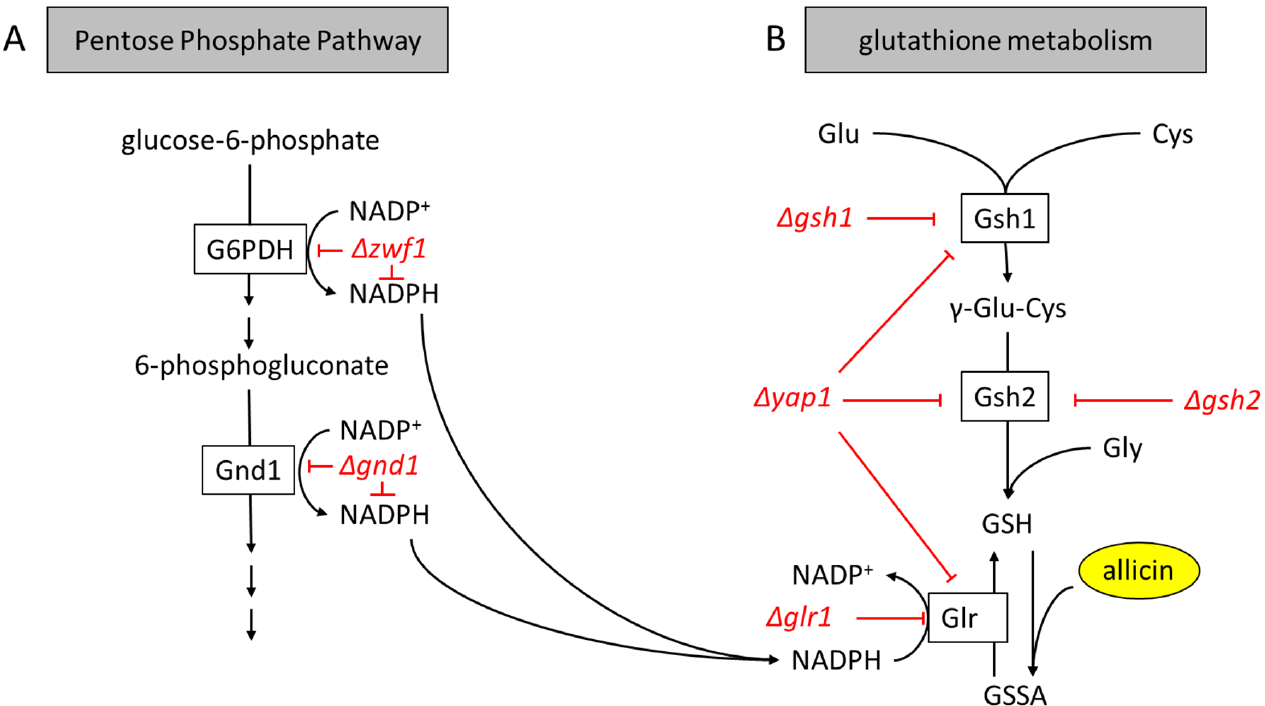
Figure 3. Summary of mutants in GSH synthesis and metabolism shown to affect allicin resistance. The diagram shows ( A ) the interplay between the NADPH-generating steps of the Pentose Phosphate Pathway and ( B ) GSH synthesis and metabolism. The steps at which the respective deletion mutants ( ∆ zwf1, ∆ gnd1, ∆ yap1 , ∆ gsh1, ∆ gsh2, ∆ glr1 ) act in yeast cells are shown in red. Allicin reacts directly with reduced glutathione (GSH) to form S -allylmercaptoglutathione (GSSA). The Pentose Phosphate Pathway provides NADPH as an electron donor for the enzyme glutathione reductase (Glr), that reduces GSSA to GSH and allylmercaptan (ASH, prop-2-ene-1-thiol). Yap1 is the central regulator for the oxidative stress response in yeast and activates several genes important for the antioxidant response, including gsh1 and gsh2 whose protein products catalyze GSH biosynthesis, and glr1 which is necessary for the reduction of GSSG and GSSA to GSH by Glr1. Cysteine (Cys) and glutamine (Glu) are converted to γ - L -glutamyl- L -cysteine by Gsh1, and the addition of glycine (Gly) is catalyzed by Gsh2 to form GSH.